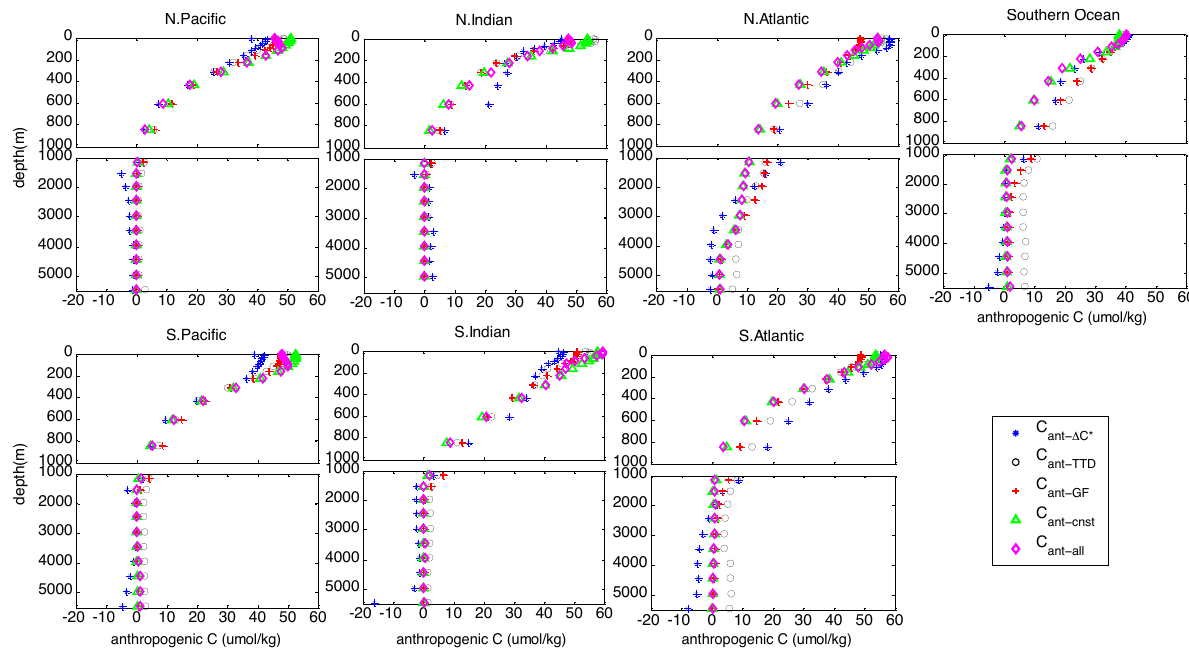
Fig. 3. Comparison of regional averaged C ant from the 1 C* method (blue asterisks), the TTD method (black circles), the GF method (red crosses), the C ant cnst from the CCSM (green triangles), and the C ant all from the CCSM (magenta diamonds). The Southern Ocean is south of 35 ◦ S. Data are vertically interpolated to compare values at the same depth.